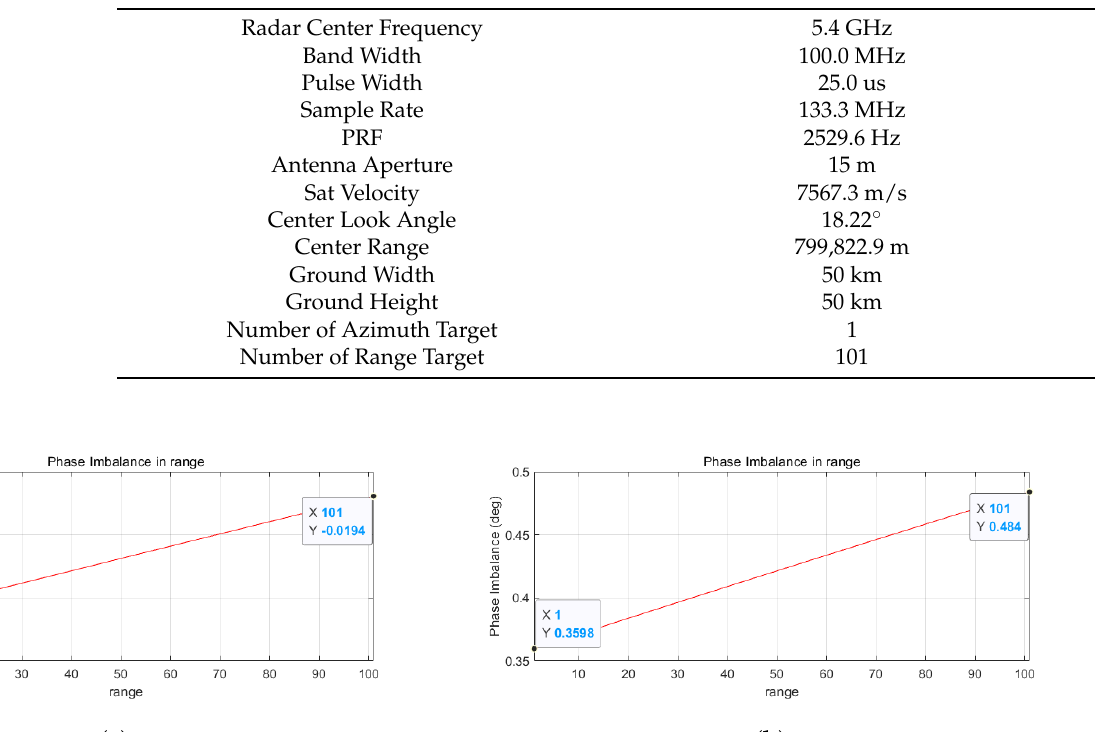
Table 6. Simulated SAR parameters.